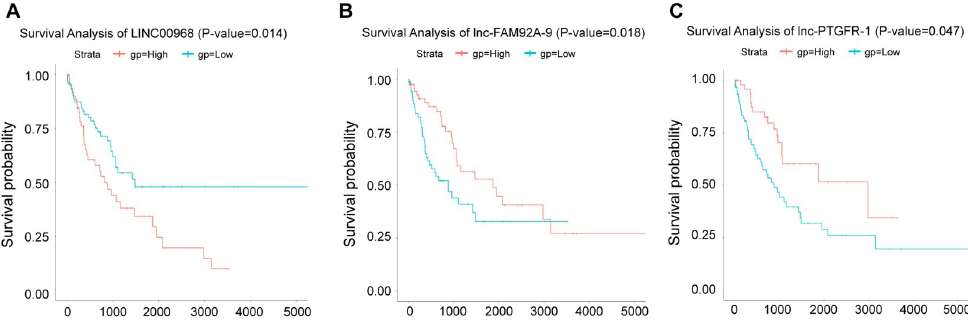
Fig 4. Survival curve of differentially expressed lncRNA. A. The survival curve of LINC00968. B. Survival curve of lnc- FAM92A-9. C. Survival curve of lnc-PTGFR-1. The abscissa represented survival time (days), and the ordinate represented survival rate. The blue line represented the low risk curve and the red line represented the high risk curve, p < 0.05.